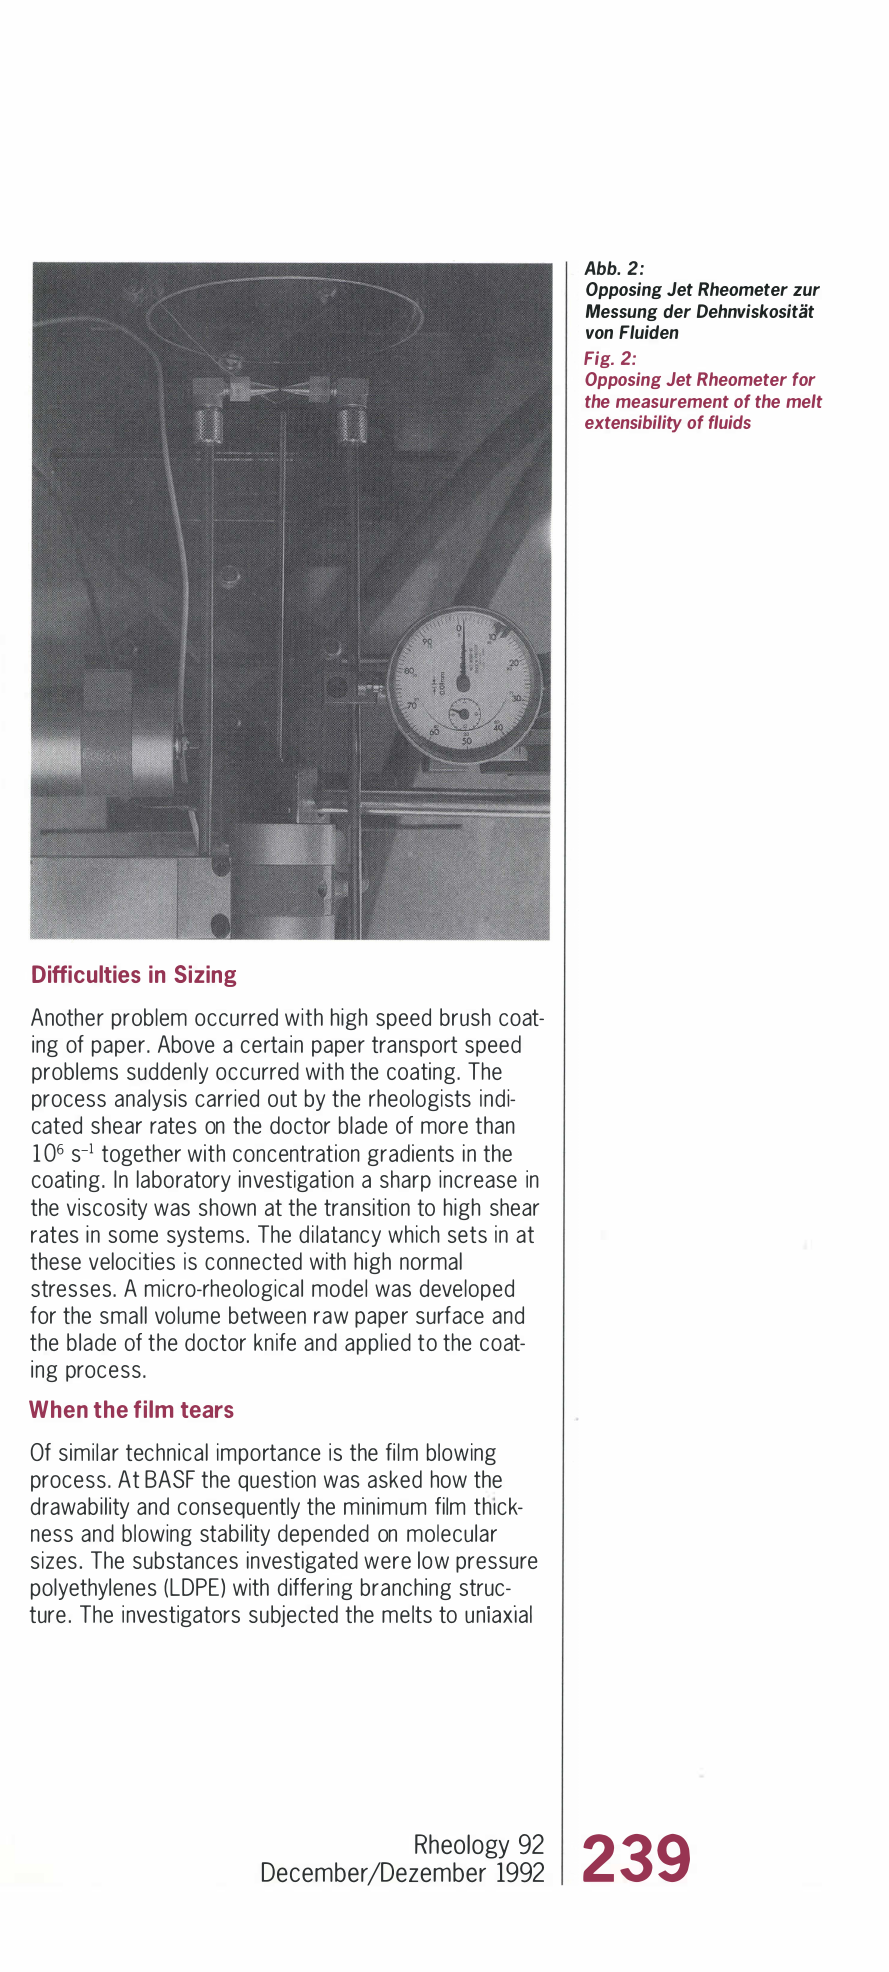
Fig. 2: Opposing Jet Rheometer for the measurement of the melt extensibility of